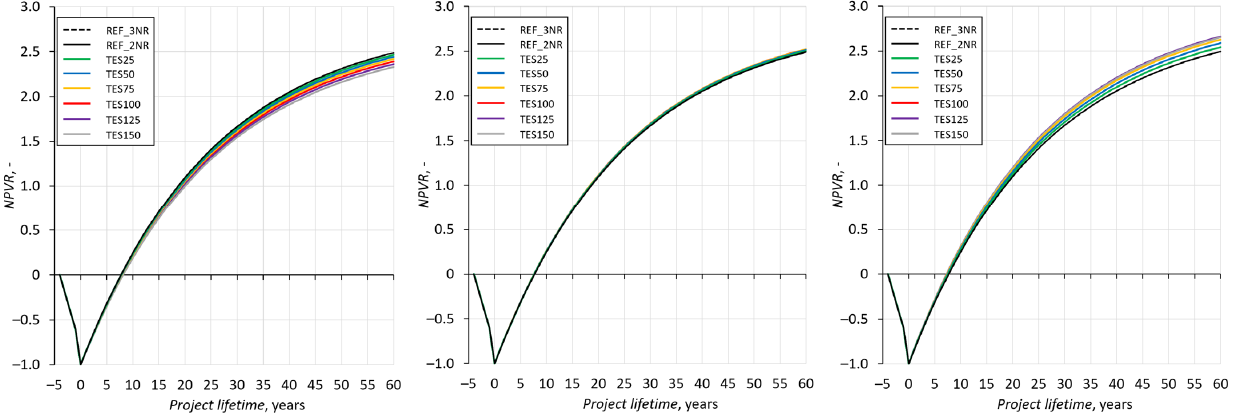
Figure 17. NPVR as a function of project lifetime for the three values of deviation index (left = − 0.2/ 0.2; central = − 0.5/0.5, and right = −